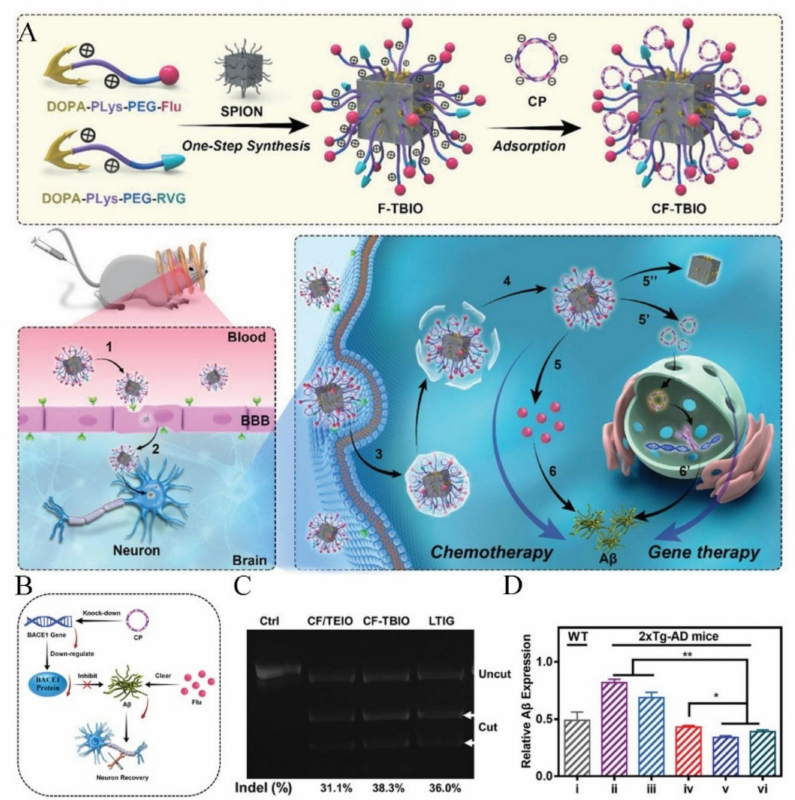
Figure 6. Illustration of CRISPR/Cas9 nano-biohybrid complexes for neurodegenerative diseases treatment. ( A ) Preparation of CF-TBIO and illustration of the therapeutic mechanism. CF-TBIO were injected through the tail vein. CF-TBIO nanoparticle crossed the BBB and targeted neurons with the guidance of RVG. The ester bonds were hydrolyzed by intracellular esterase and release Fluvastatin to clear A β . CRISPR/Cas9 plasmids then entered the nuclei and knocked out the BACE1 gene. ( B ) Diagram of CRISPR/Cas9 plasmids and Fluvastatin for AD treatment. ( C ) T7E1 assay for BACE1 indels frequency analysis in brains of double transgenic (2 × Tg-AD) mice. ( D ) Quantification of WB analysis of A β expression. (i) Wild type mice without treatment, (ii) 2 × Tg-AD mice without treatment, (iii) 2 × Tg-AD mice treated with CNSF-TBIO, (iv) CF/TEIO, (v) CF-TBIO, (vi) the mice were administrated via the tail vein every 10 days, while the other groups were every 3 days. Significant differences between groups were indicated as * p < 0.05, and ** p < 0.01. Reproduced with permission from [44]. Copyright Joh Wiley and Sons,